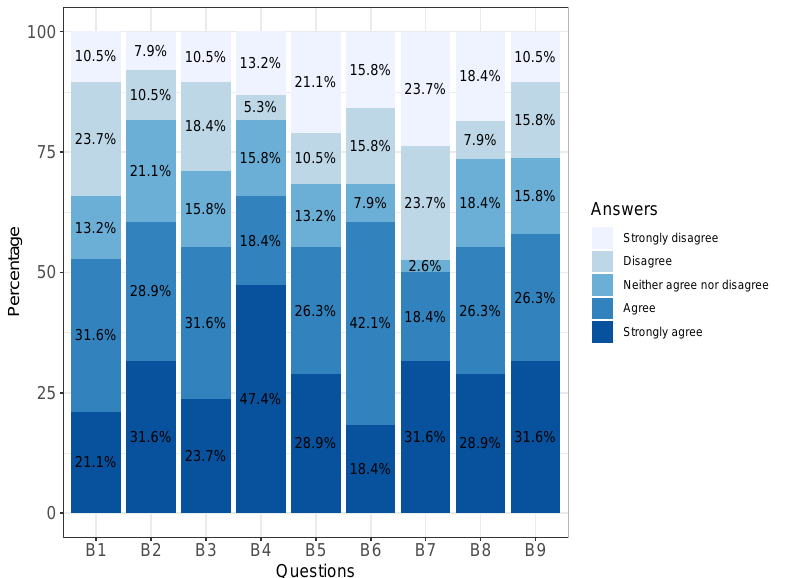
Figure 3. Percentages of satisfaction with Scratch (questionnaire Q2, Table 1).